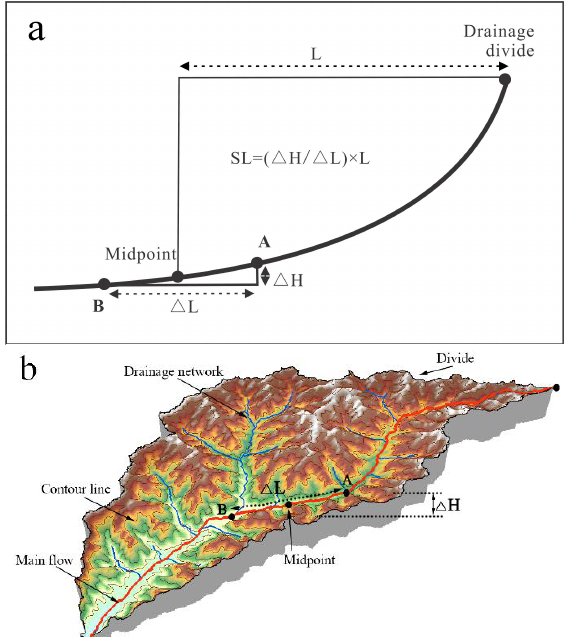
Basin.Figure 3. Parameters used in calculation of gradient index, modified from (Hack,